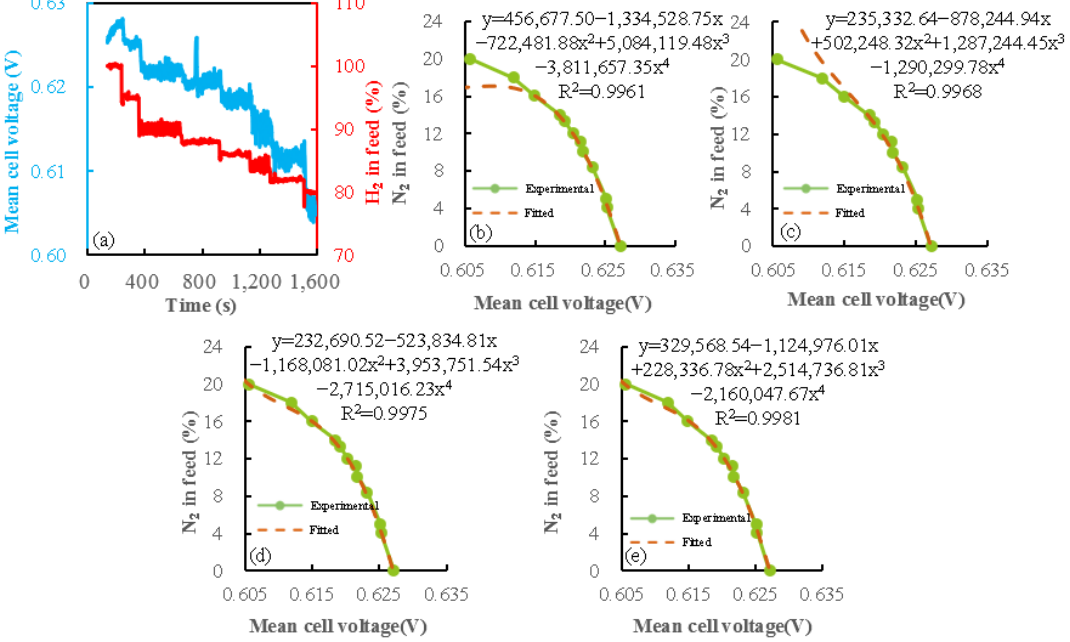
Figure 12. Prediction and validation for 1.6 A ∙ cm − 2 : ( a ) Test results; ( b ) Prediction and validation of data based on 0–16% nitrogen concentration; ( c ) Prediction and validation of data based on 0–17% nitrogen concentration; ( d ) Prediction and validation of data based on 0–18% nitrogen concentration; ( e ) Prediction and validation of data based on 0–20% nitrogen concentration.